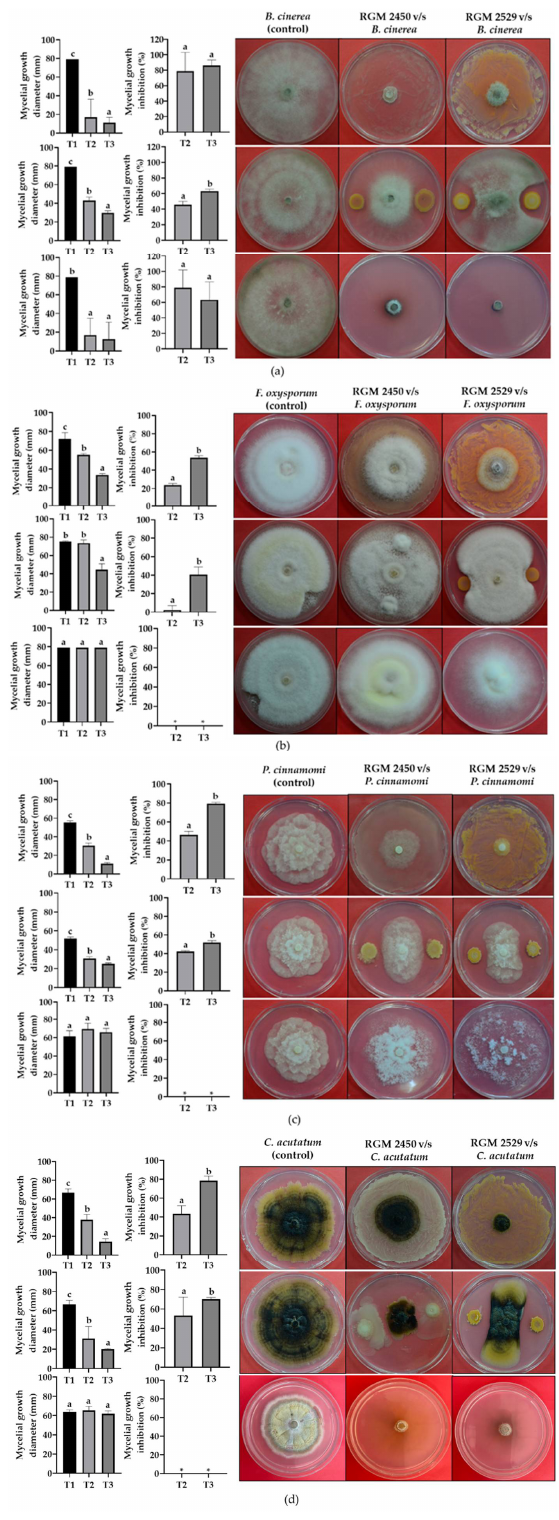
Figure 3. Antagonistic effect of B. safensis RGM 2450 and B. siamensis RGM 2529 against phytopathogenic fungi ( a ) B. cinerea , ( b ) F. oxysporum , ( c ) P. cinnamomi , ( d ) C. acutatum . Treatments: T1, phytopathogenic fungus. T2, strain B. safensis RGM 2450 vs. phytopathogenic fungus strain. T3, strain B. siamensis RGM 2529 vs. phytopathogenic fungus strain. Letters on the bars represent the comparison using an LSD test ( α = 0.05) between treatments. Different letters in each figure represent statistically significant differences. * means that there is no measurable percentage of